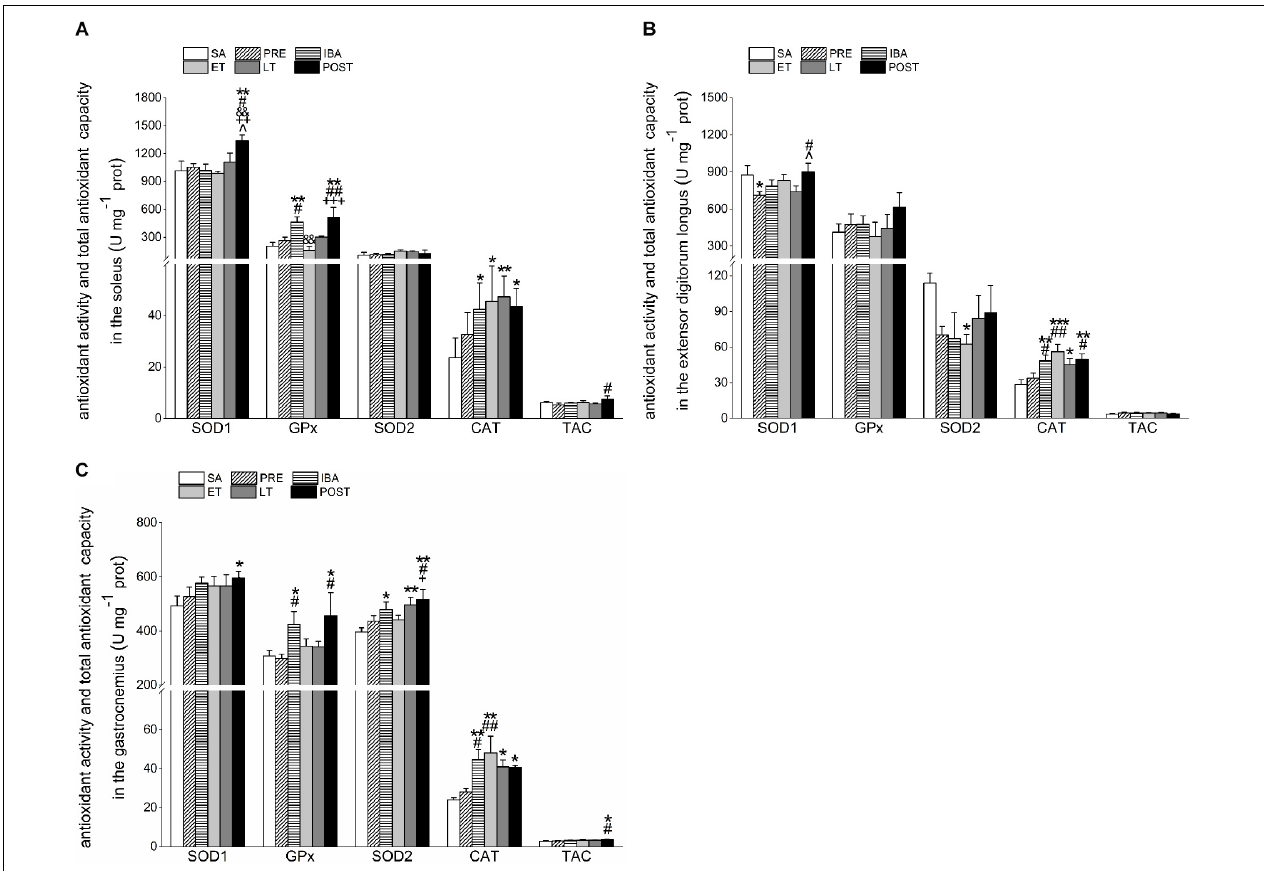
FIGURE 6 | Changes in activities of SOD1, SOD2, CAT, GPx1, and TAC in different skeletal muscles of Daurian ground squirrels over the torpor-arousal cycle. (A) Activities of SOD1, SOD2, CAT, GPx, and TAC in SOL during six hibernation periods. (B) Activities of SOD1, SOD2, CAT, GPx, and TAC in EDL during six hibernation periods. (C) Activities of SOD1, SOD2, CAT, GPx, and TAC in GAS during six hibernation periods. SA, summer active; PRE, pre-hibernation; IBA, interbout arousal; ET, early torpor; LT, late torpor; POST, post-hibernation; SOL, soleus; EDL, extensor digitorum longus; GAS, gastrocnemius. Values are means ± SEM, n = 8. ∗ P < 0.05, Compared with SA; ∗∗ P < 0.01, compared with SA; ∗∗∗ P < 0.001, compared with SA; # P < 0.05, compared with PRE; ## P < 0.01, compared with PRE; && P < 0.01, compared with IBA; + P < 0.05, compared with ET; ++ P < 0.01, compared with ET; +++ P < 0.001, compared with ET; ∧ P < 0.05, compared with